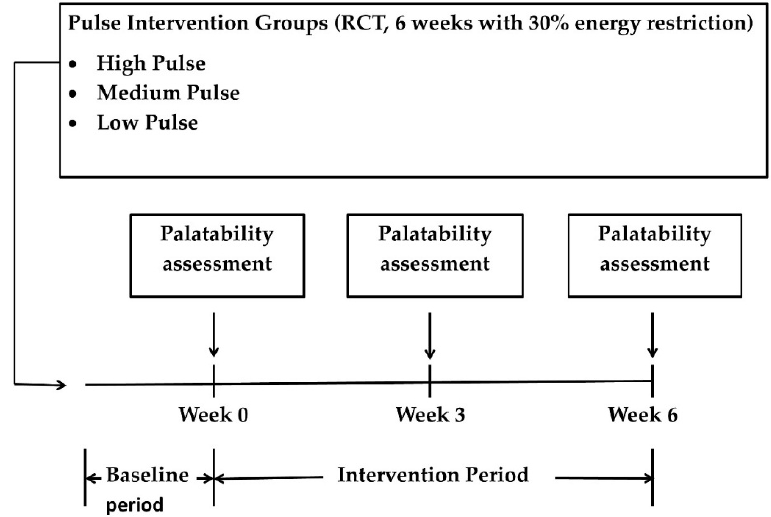
Figure 1. Schematic of Study Design. RCT, randomized controlled trial. Table 1. The 28-food item taste test battery for study participants classified according to exposure and food types.